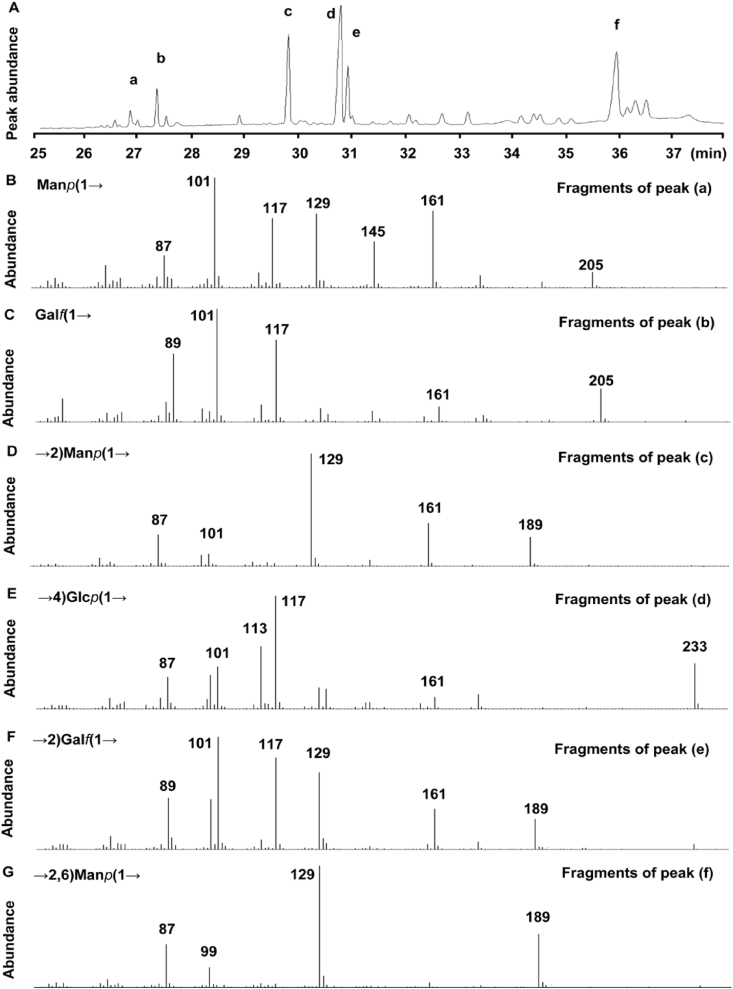
The total ion chromatogram of CM1 and their characteristic fragments as measured by GC-MS. (A), the characteristic GC-MS spectrum of CM1 after complete methylation; (B), characteristic fragments of the glycosyl Manp(1→; (C), characteristic fragments of the glycosyl Galf(1→; (D), characteristic fragments of the glycosyl →2)Manp(1→; (E), characteristic fragments of the glycosyl →4)Glcp(1→; (F), characteristic fragments of the glycosyl →2)Galf(1→; (G) characteristic fragments of the glycosyl →2,6)Manp(1→.